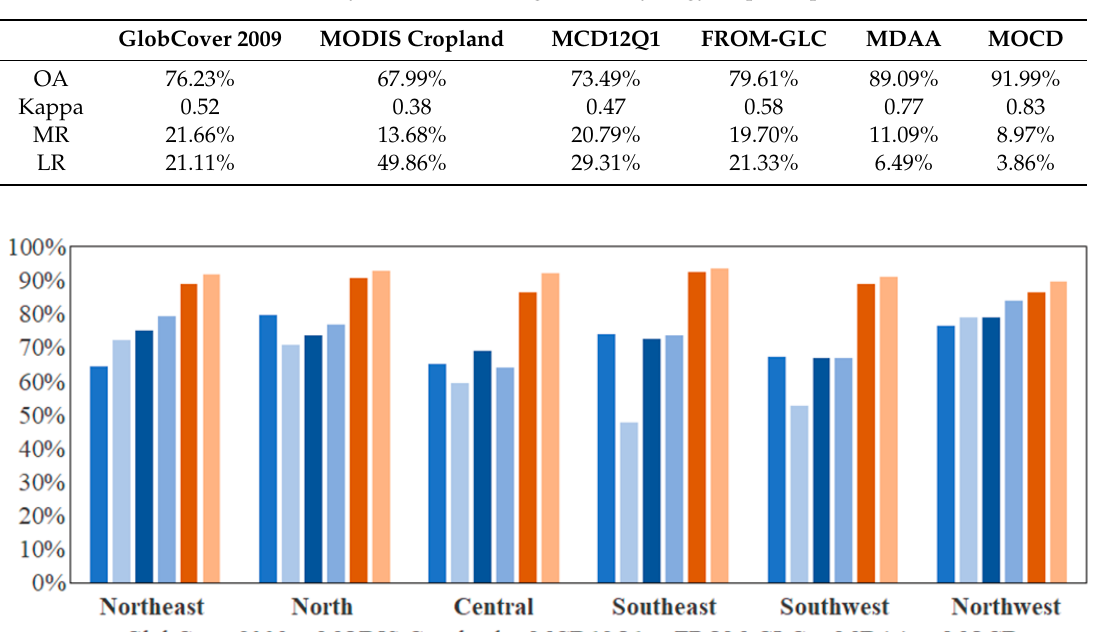
Table 3. Accuracy indices of the original and synergy cropland products.